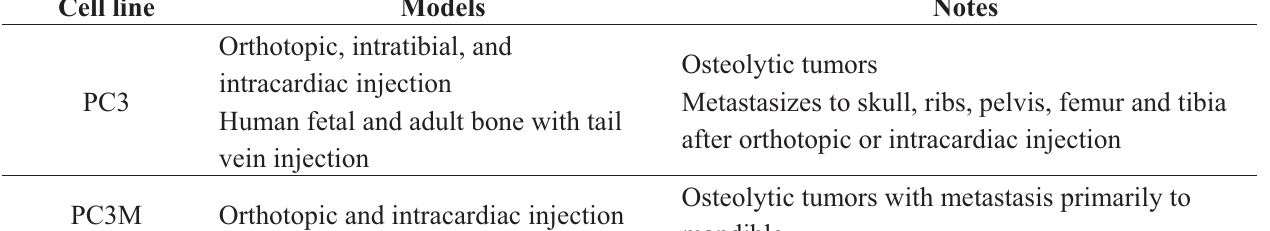
Table 2. Human Cell and Tumor Lines used to Model Bone Metastasis in